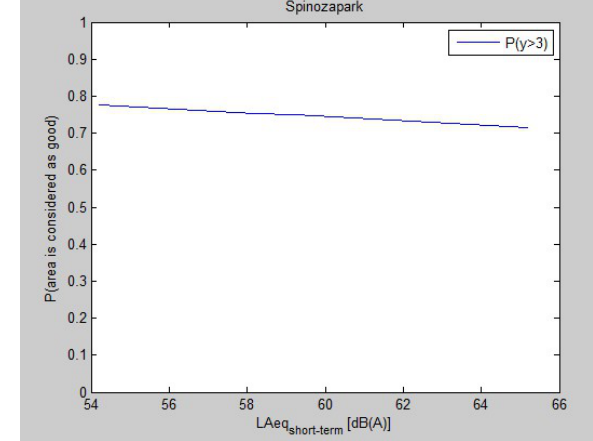
Figure 8: Probability that end users consider an area as good (score of at least 3 out of 5) as the evaluation of the well-maintainance (score from 1 to 5) changes in Spinoza